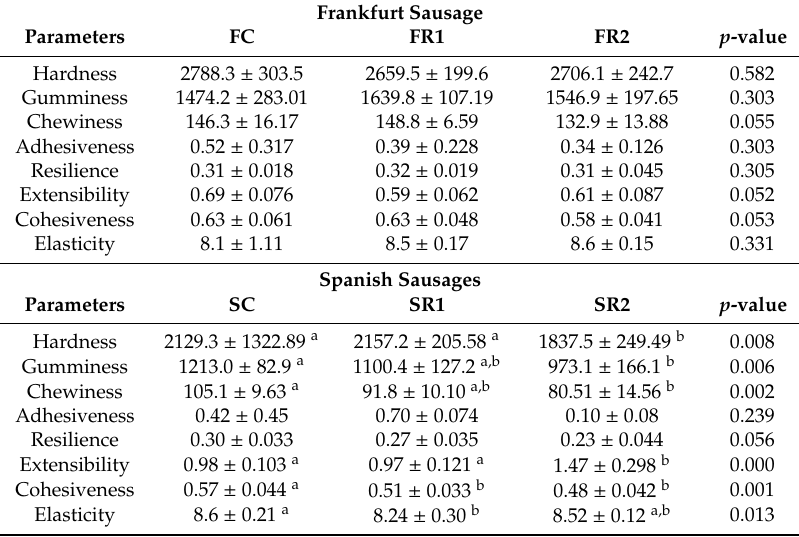
Table 4. Instrumental texture means ± SD of Frankfurt and Spanish